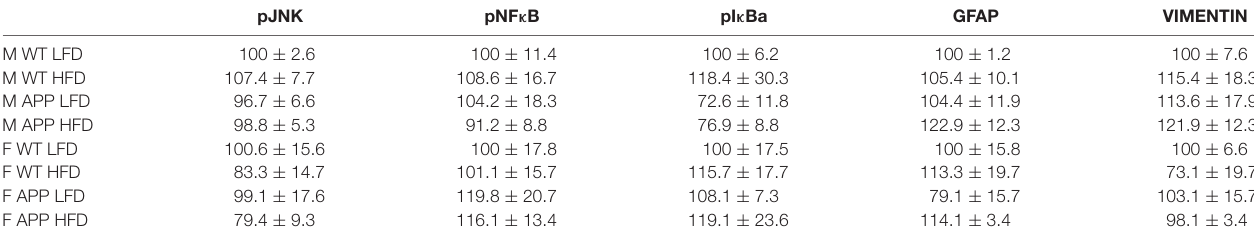
TABLE 7 | Protein levels of phosphorylated jun N terminal kinase (pJNK), pNF κ B, pI κ Ba, glial fibrillary acidic protein (GFAP), and vimentin in the hypothalamus, expressed as a % of the correspondent WT LFD (male or female) group.